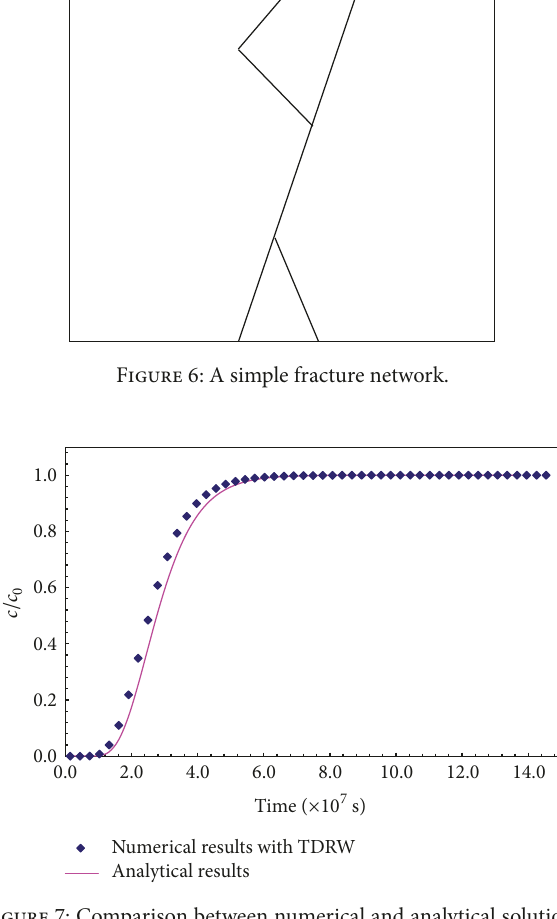
Figure 7: Comparison between numerical and analytical solutions of particle transport in a simple fracture